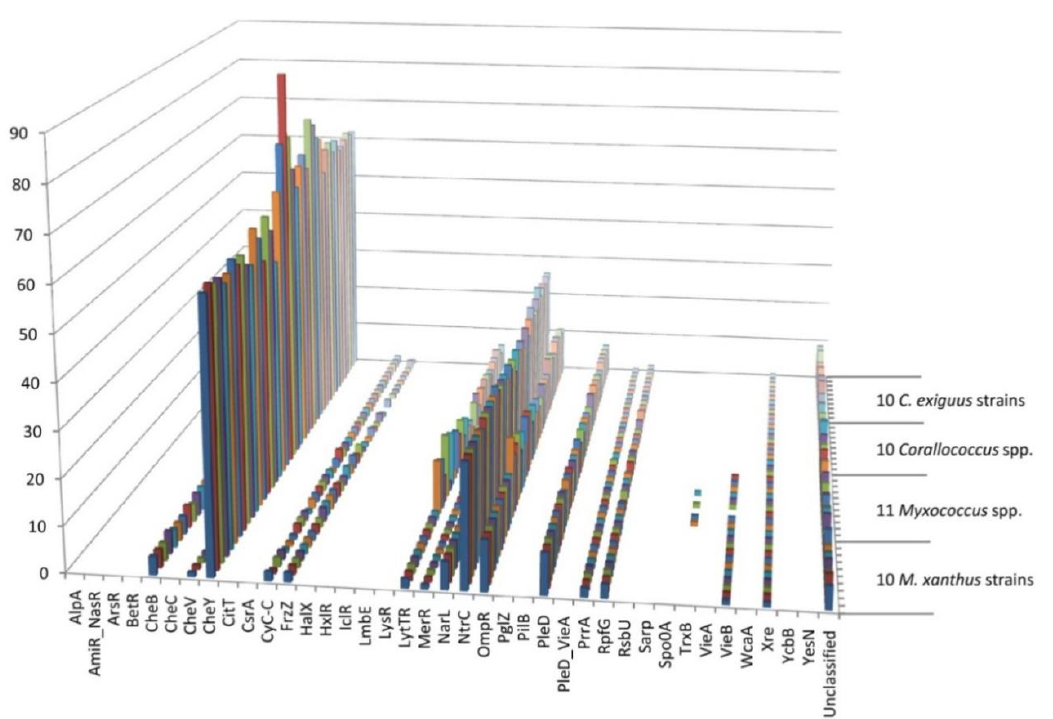
Figure 1. Response regulator (RR) families encoded in myxobacterial genomes. The strains under consideration are in the same order (front to back) as those detailed in Table 1 (top to bottom). Different strains and species exhibit similar profiles of RR families, although conserved differences can be seen in some groups of genomes.